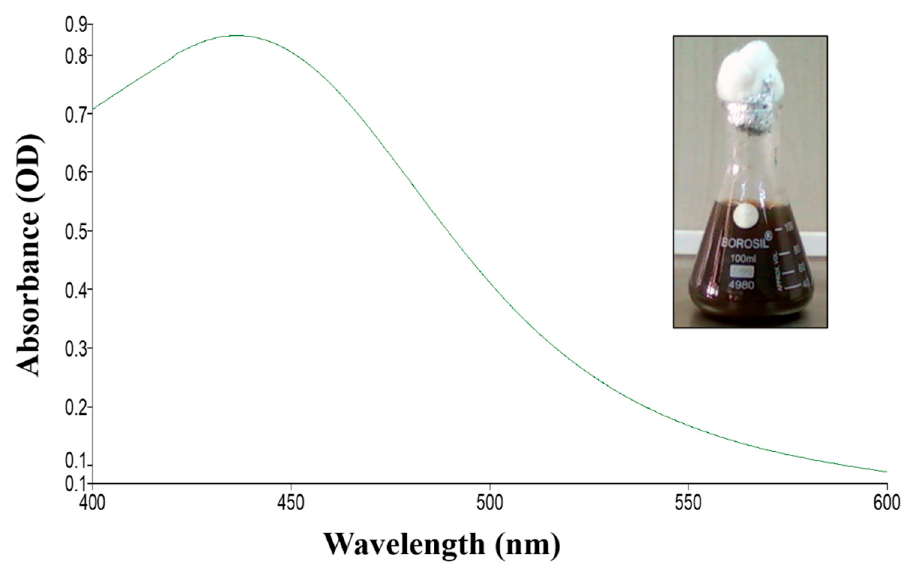
Figure 1. UV-Visible spectrophotometric analysis of AgNPs synthesized using Talaromyces funiculosus .